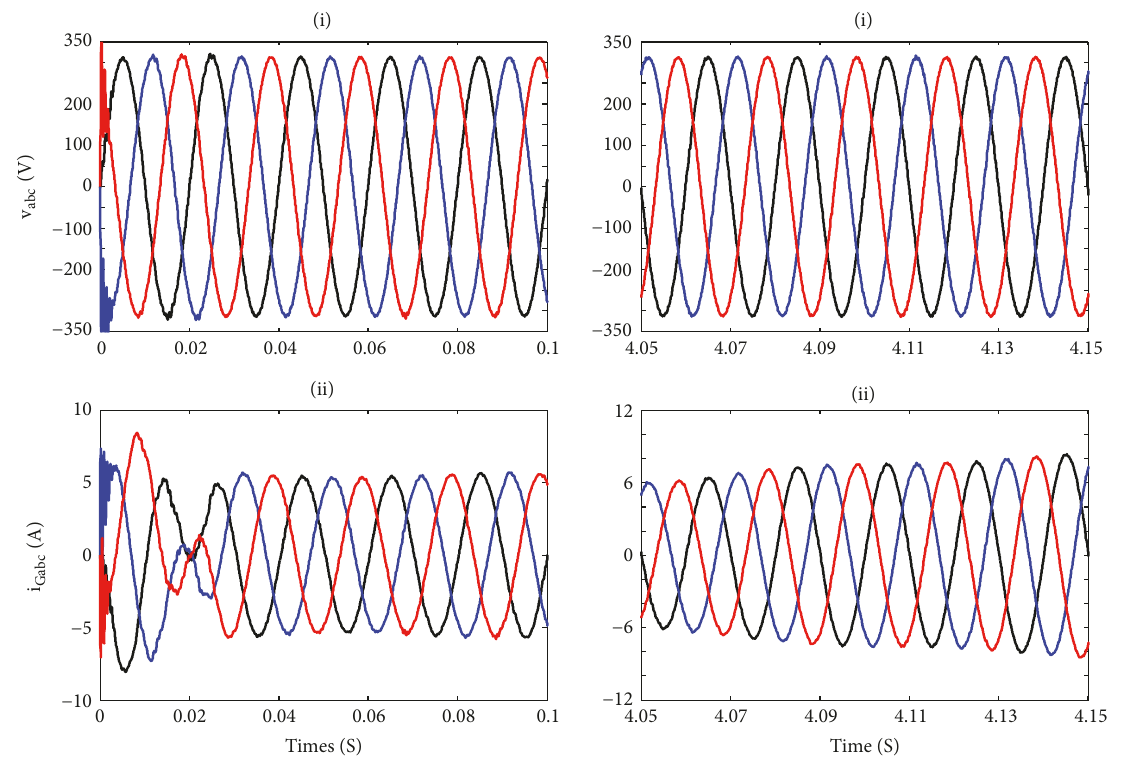
Figure 9: Control system response to wind speed fluctuations with nominal values of parameters. Zoom on (proposed RBF-NSMC): (i)